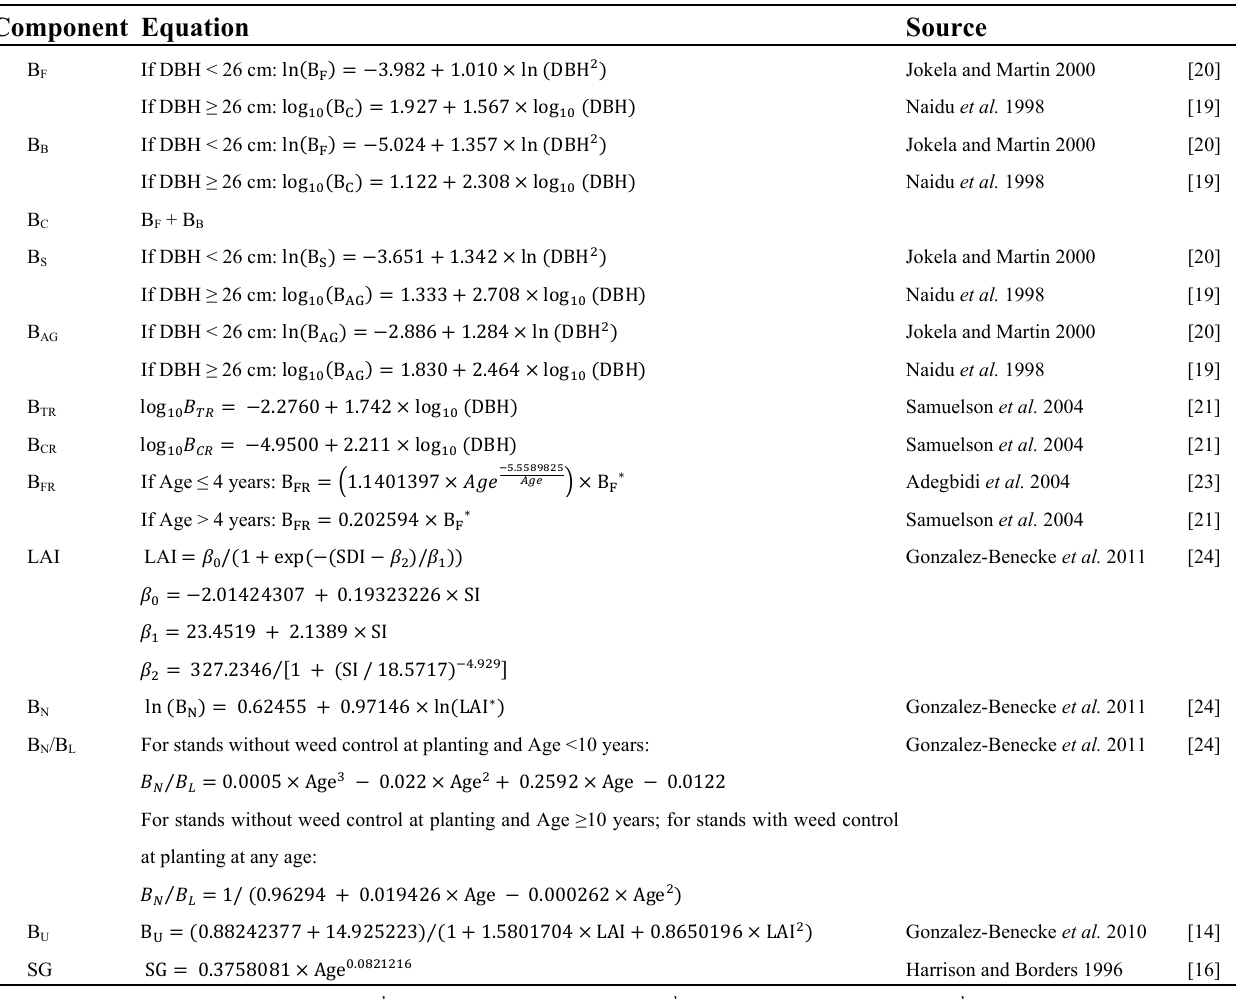
Table 1. Allometric equations used to estimate loblolly pine aboveground (needles, branches and stem plus bark) and belowground (tap, coarse and fine roots), forest floor and understory